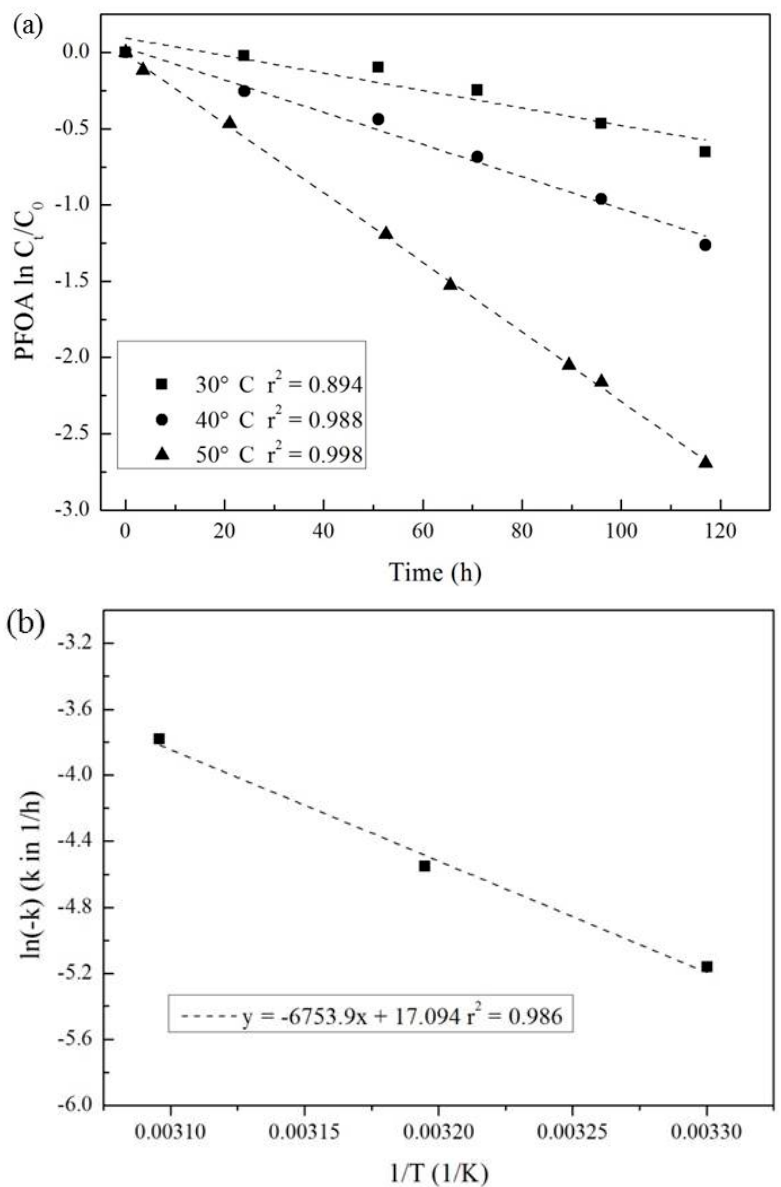
Figure 4. ( a ) The pseudo-first-order kinetic plots of PFOA degradation by activated persulfate under acidic conditions ([PFOA] 0 = 20 μ M; molar ratio of PFOA to persulfate = 1:100; temperature = 30 °C, 40 °C, acidic conditions ([PFOA] 0 = 20 µ M; molar ratio of PFOA to persulfate = 1:100; temperature = 30 ˝ C, 50 °C; pH adjusted by H 2 SO 4 to 2.0); ( b ) Arrhenius plot of the pseudo-first-order degradation constants. 40 ˝ C, 50 ˝ C; pH adjusted by H 2 SO 4 to 2.0); ( b ) Arrhenius plot of the Table 1. Pseudo-first-order kinetic constant (k) of PFOA degradation by activated persulfate under